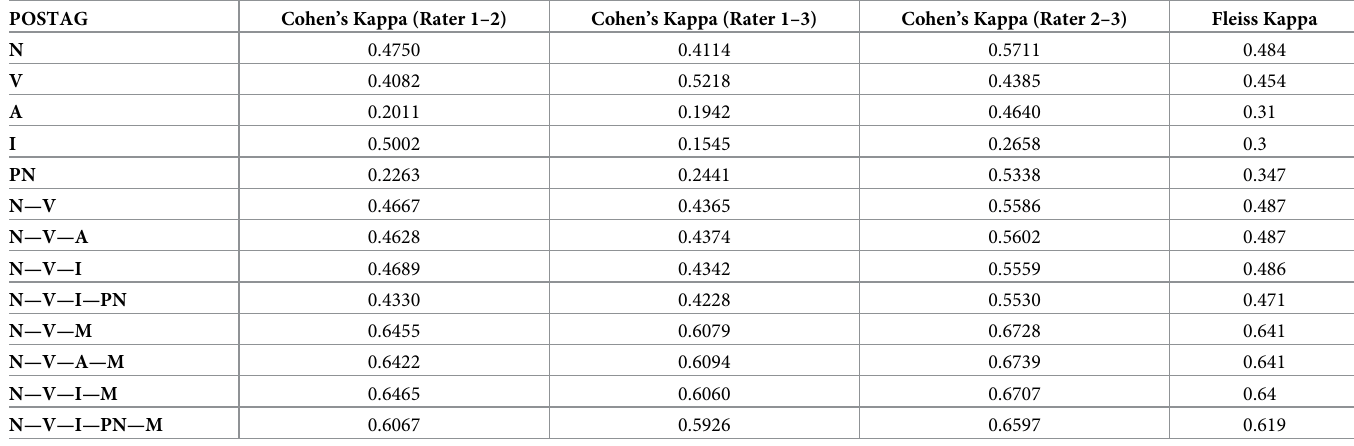
Table 4. EASIER corpus—CWI dataset results where N: nouns, V: verbs, A: adverbs, I: Interjections, PN: proper nouns, M: multi- words.